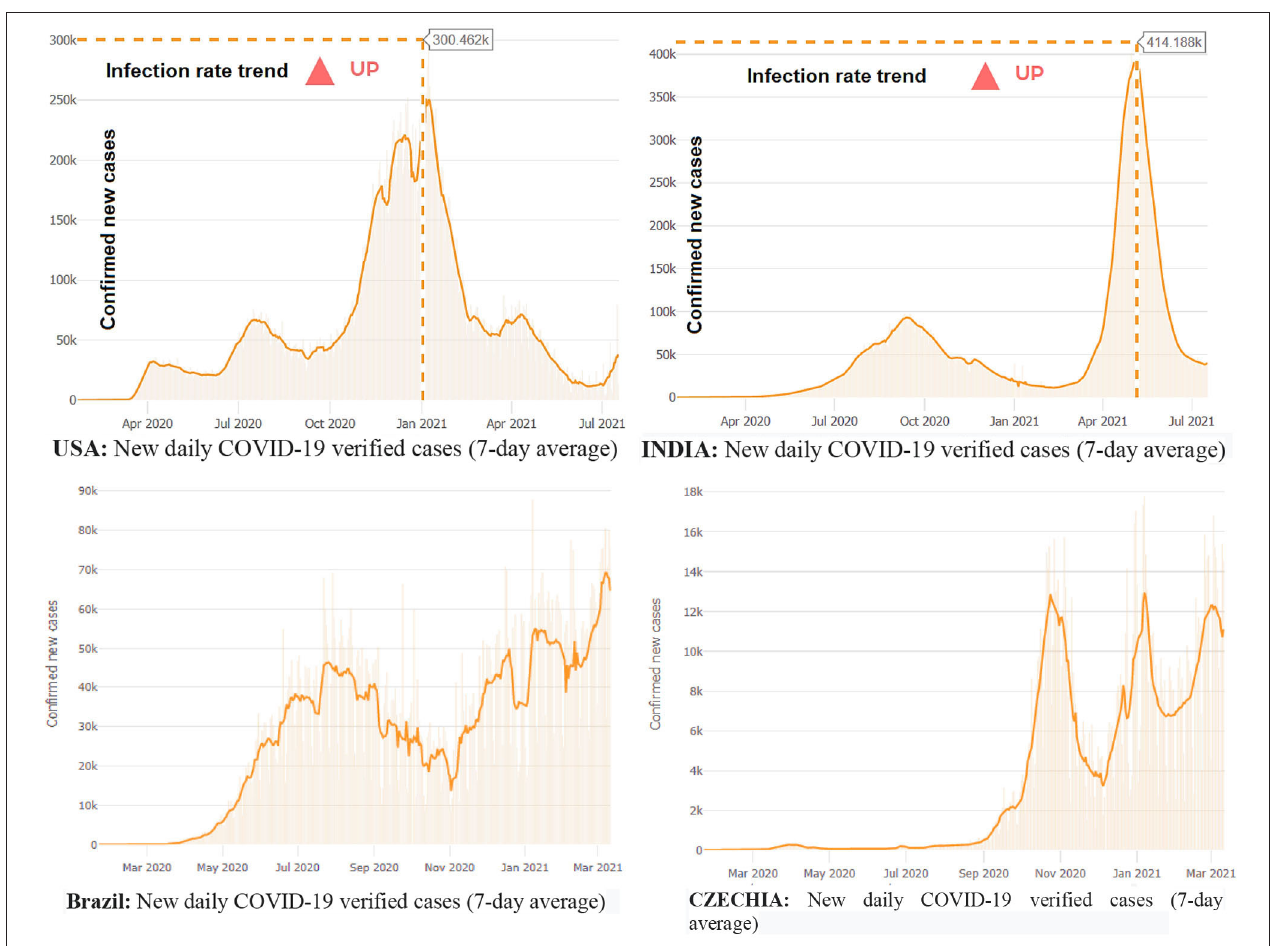
FIGURE 3 | COVID-19 waves, positive cases in the USA, Brazil, India, and Czechia, July 18, 2021. Source: WHO and JHU CSSE data on COVID-19 disease.